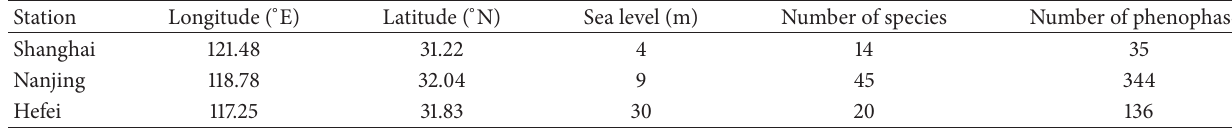
Table 1: Geographical information of the 3 phenological observation stations.